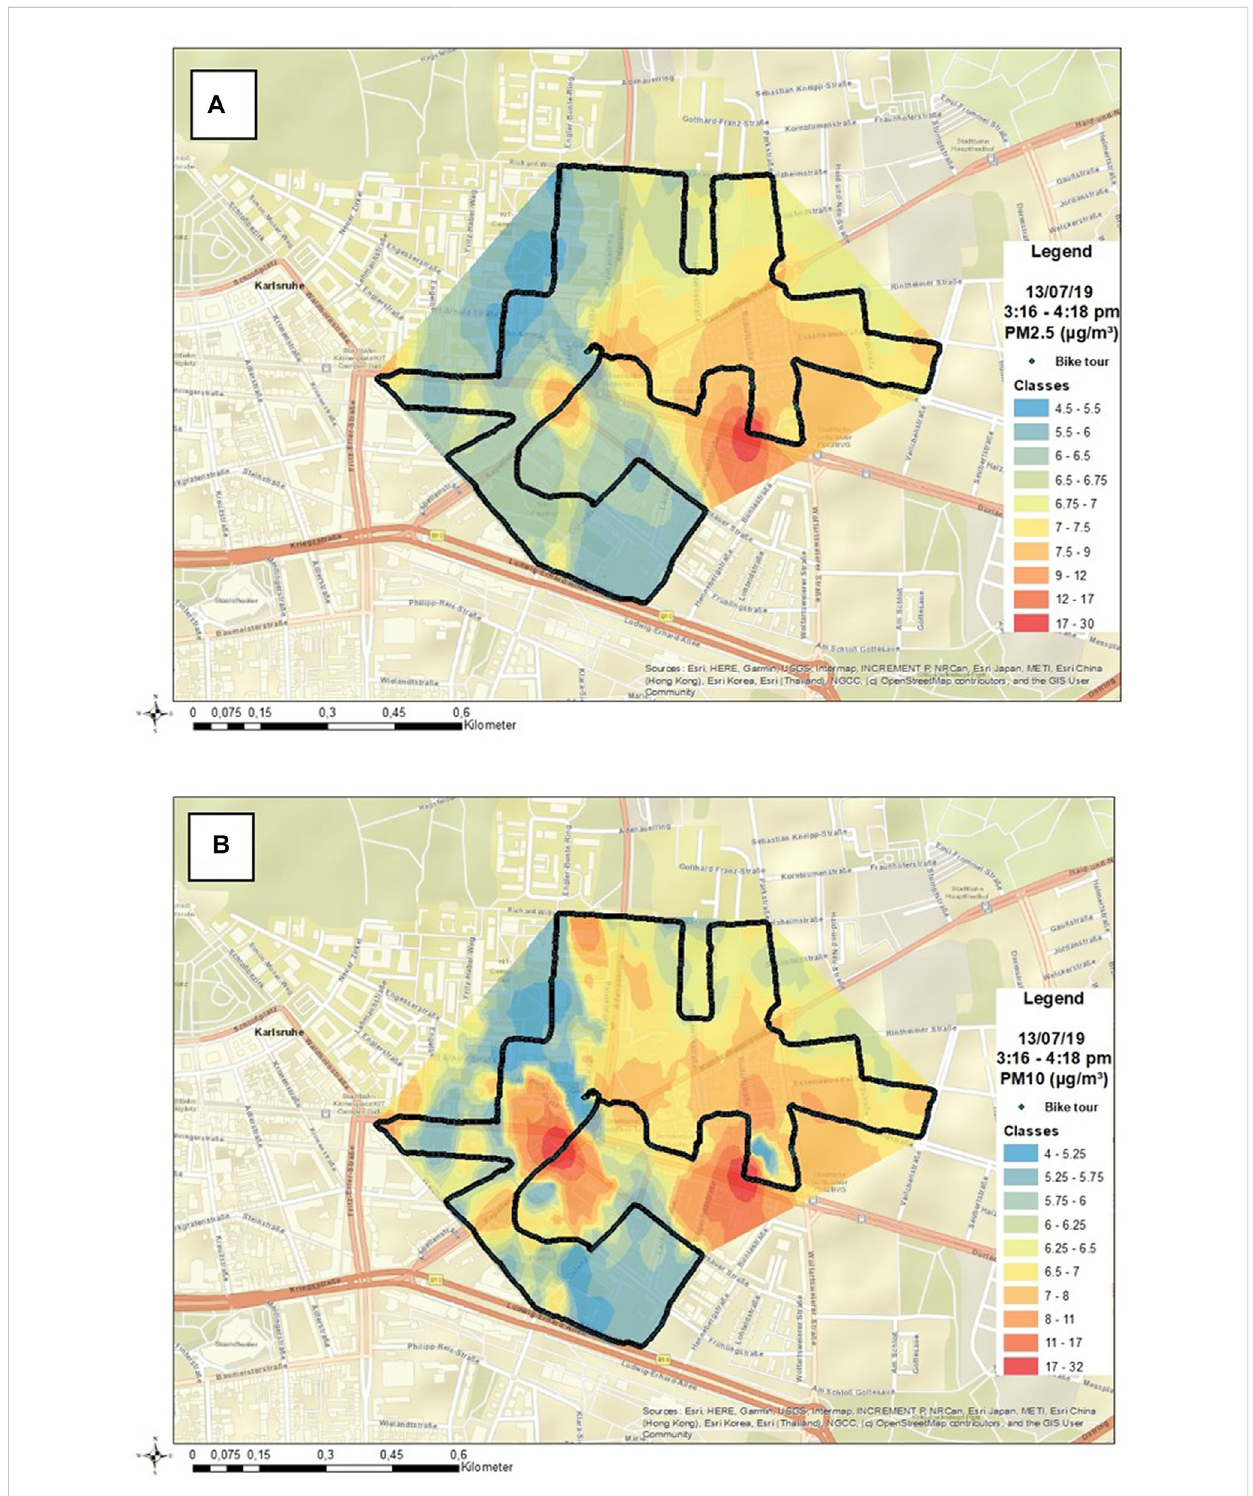
comparing PM 10 and PM 2.5 patterns of the same monitoring tour. It has to be stated that the interpolation is not considering the building structure and is assuming an area without